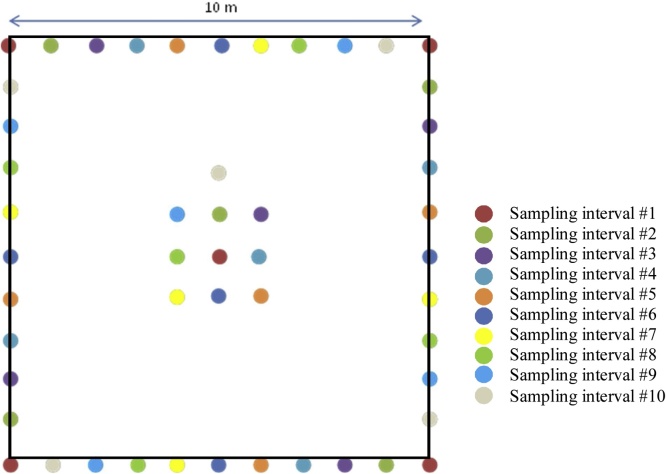
Sampling layout for repeat sampling within each 10 × 10 m plot on the wellsite and reference sites.Each colour represents a different sampling interval, for a total of 10 sampling intervals.